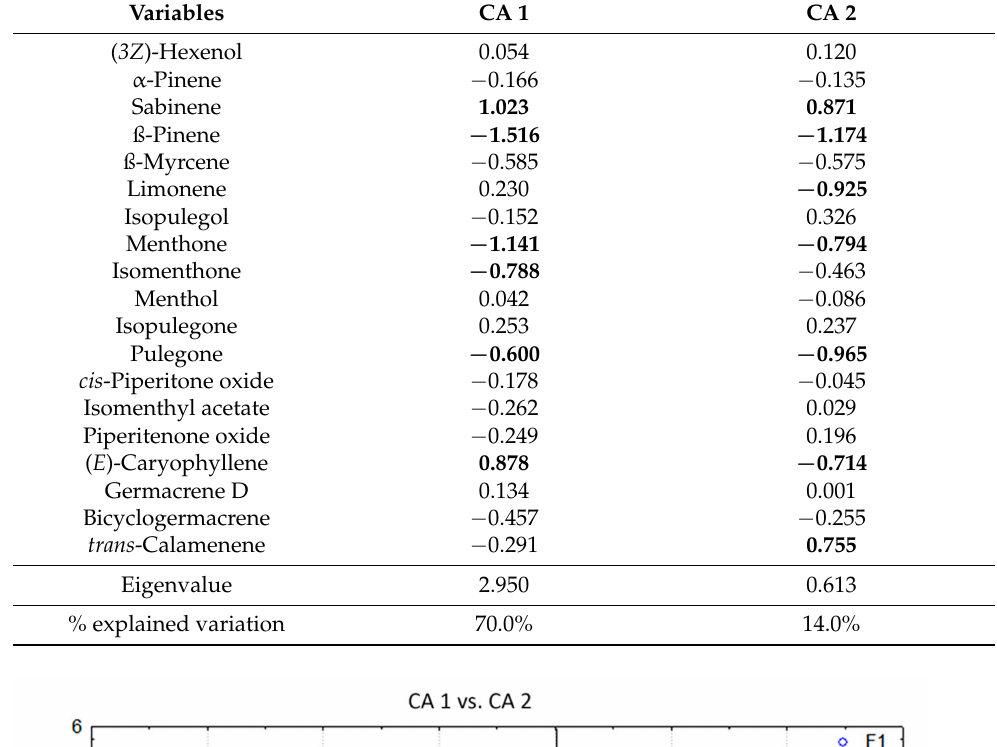
Standardized coefficients for the first two canonical axes (CA) of variation in 19 Clinopodium pulegium HS volatiles from the discriminant functional analysis of seven a priori groups. Significant coefficients are in boldface.